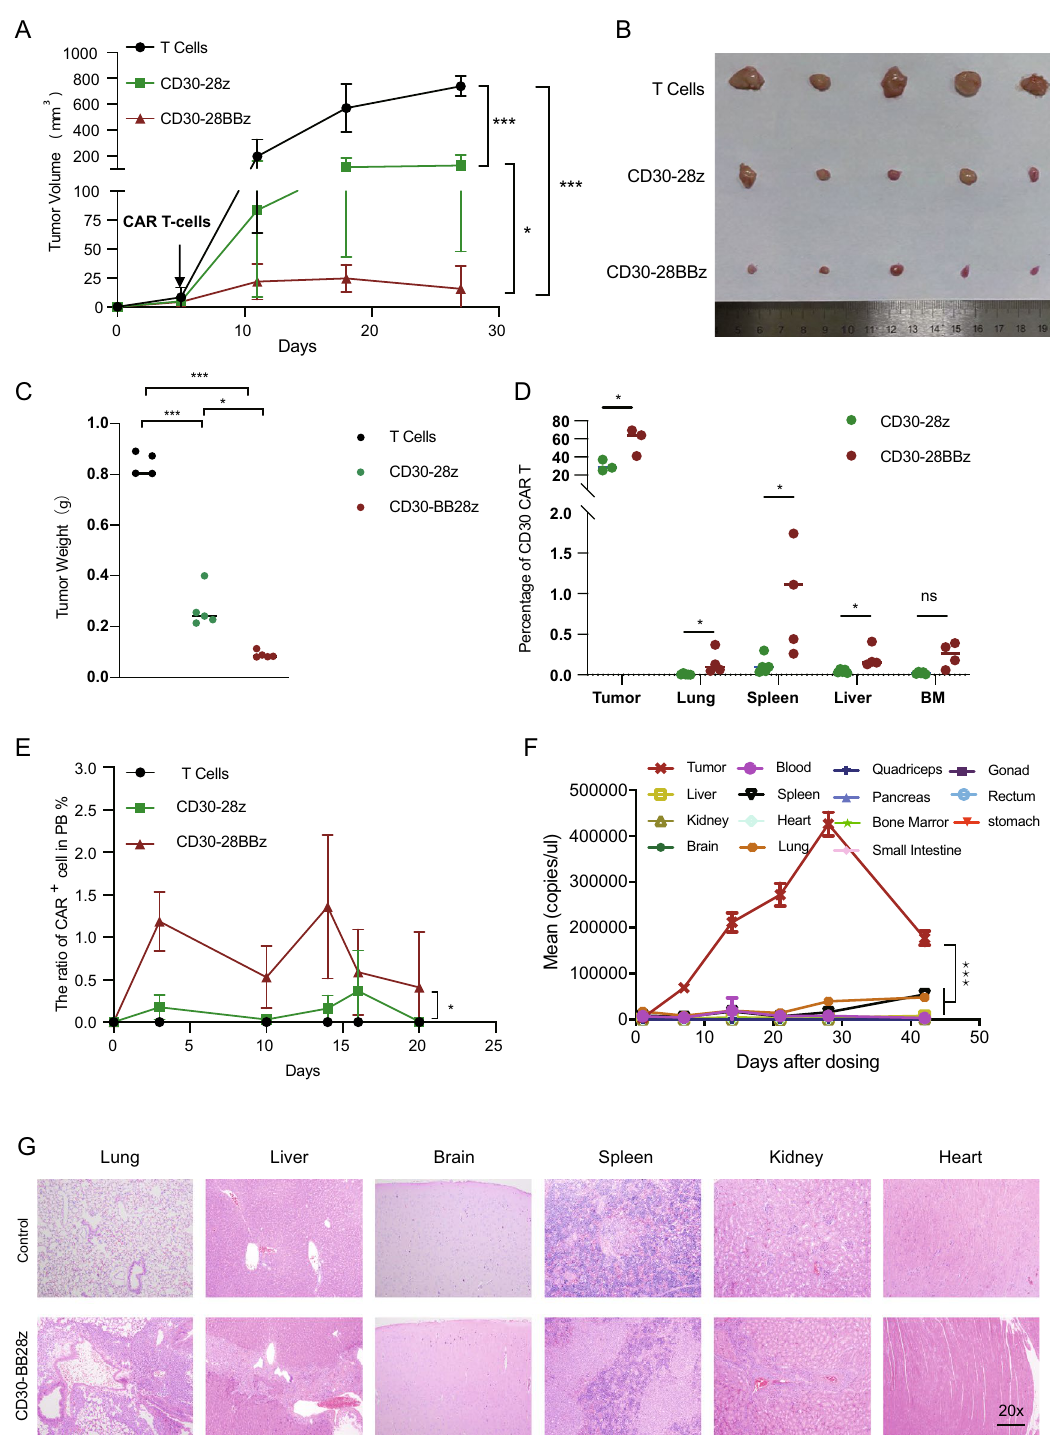
Figure 3. In vivo anti-tumor activity of anti-CD30 CAR T-cells. (A) Effect of anti-CD30 CAR T-cells (CD30- 28z and CD30-28BBz) on tumor volume in L428 xenografts (n = 5). (B,C) Spleens from different treatment groups were weighed(B) and photographed(C) in L428 derived mice model(n = 5). (D) Percentage of anti-CD30 CAR positive cells in tumour and different mouse organs. (E) Detection of anti-CD30 CAR T-cells in the peripheral blood using flow cytometry for mouse model as the time indicated. Cells were gated on T lymphocytes identified as hCD45+ and hCD3+ cells. (F) Anti-CD30 CAR T-cell expansion and persistence in different organs. Three mice were sacrificed at each of several serial time points and q-PCR was performed to determine the expression of the CAR in different organs. (G) Images of H&E-staining of lung, liver, brain, spleen, kidney and heart tissue from mice receiving untransfected T cells or anti-CD30 CAR T-cells (CD30- 28BBz). All experiments were performed at least three independent times, and *p ≤ 0.05; **p ≤ 0.01; ***p ≤ 0.001. (A–E) Black bar: T cells; green bar: CD30-28z; red bar: